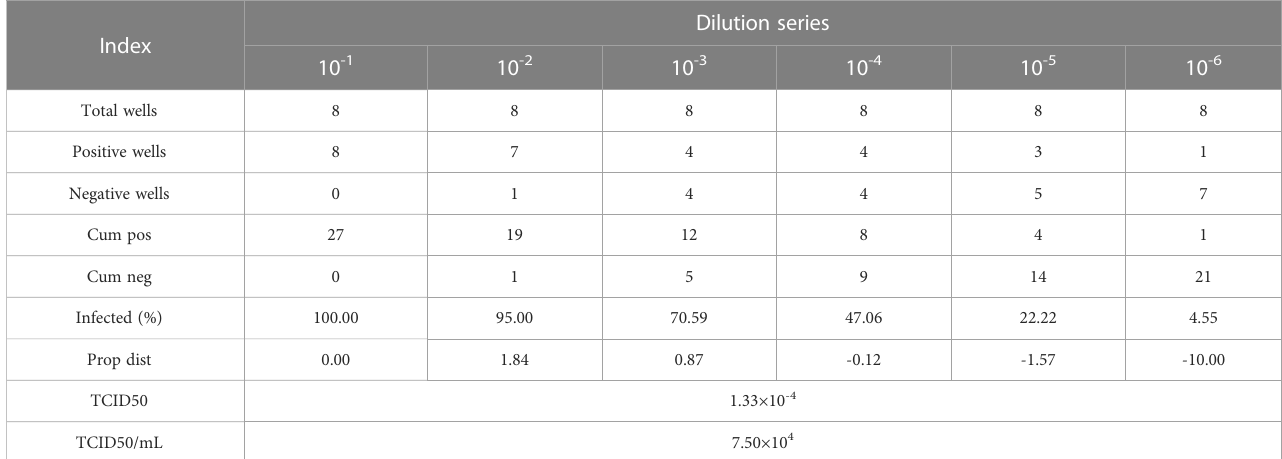
TABLE 2 Calculate the TCID50 of HIV-1 pseudovirus by Reed&Muench